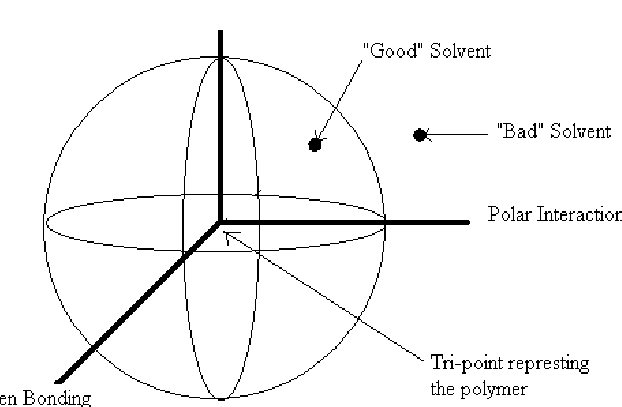
Figure 2. A three-dimensional plot of the three solubility parameter (SP) contributions i.e. , ), dipolar interactions ( δ ), and H-bond capacity ( δ ), to the total SP dispersion forces ( δ d p h ). The tri-point represents a hypothetical polymer. Interaction radius is the shortest ( δ T distance between the tri-point and the